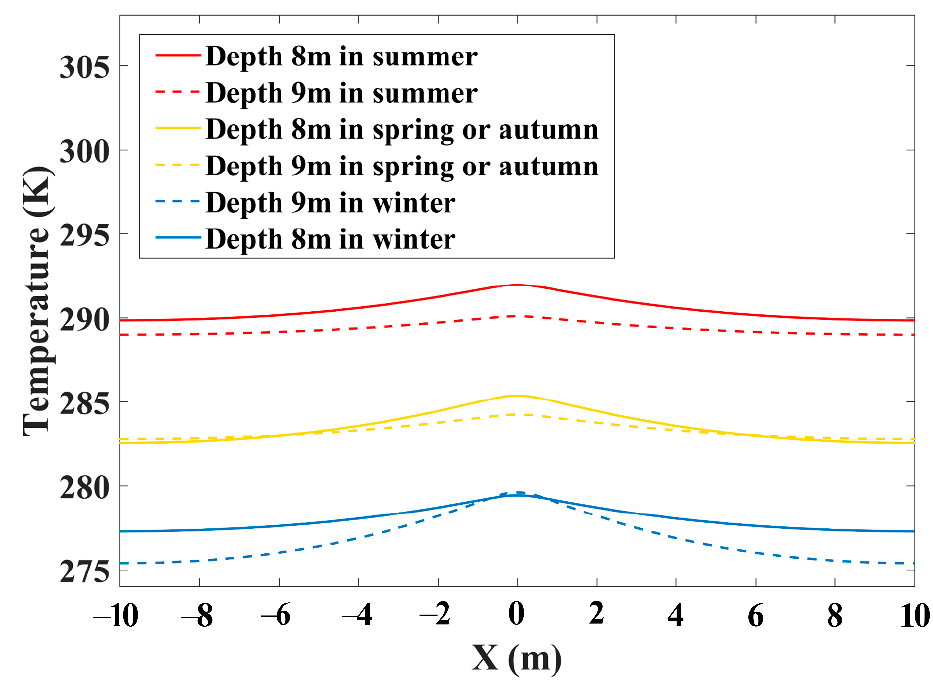
Figure 18. Temperature distribution at depth of 8 m and 9 m in different seasons.